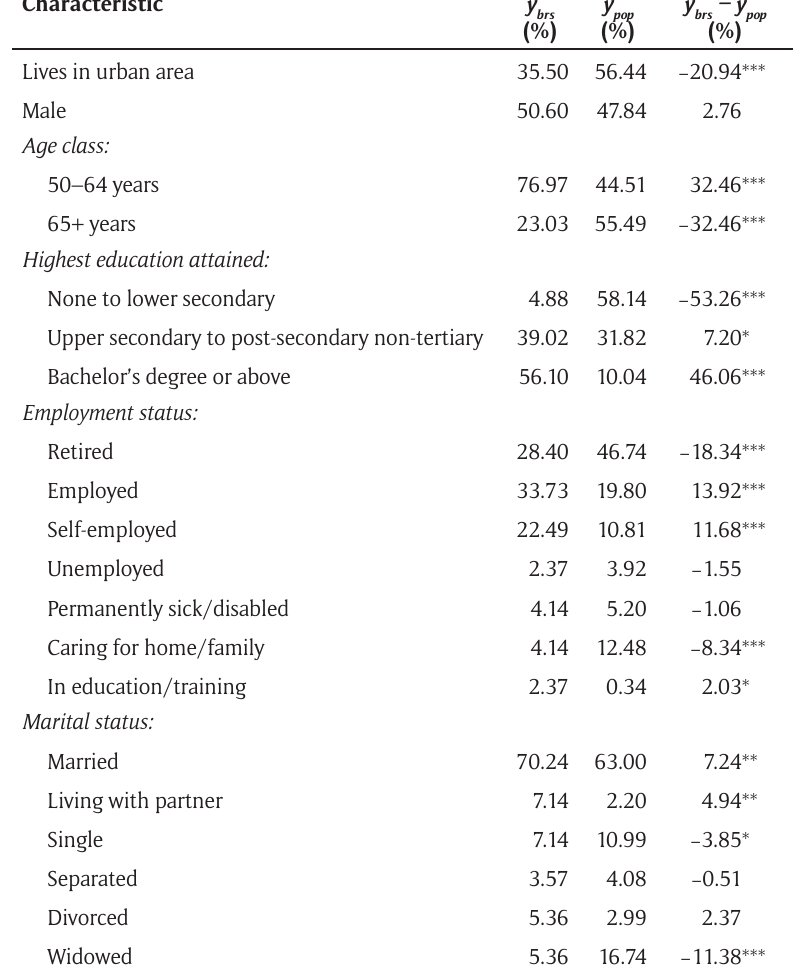
Table 2: Demographic characteristics of biodiversity recorders compared with older adult population in Ireland using The Irish Longitudinal Study on Ageing